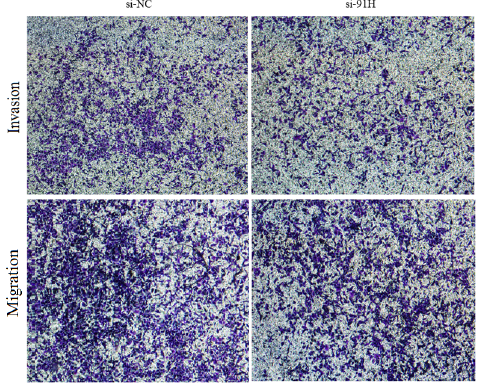
Figure 10. Apoptosis was investigated using cytometric analysis at 48 h after infection with si-91H or si-NC. Data were representative of three separate experiments.